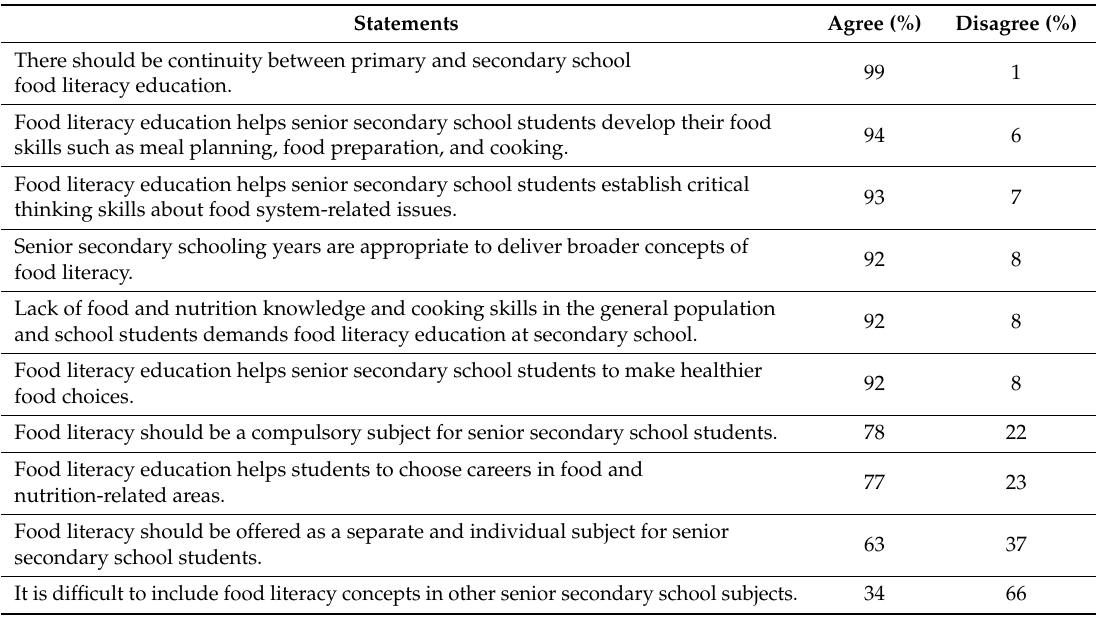
Table 2. Respondents’ agreement with statements related to the importance of food literacy education for senior secondary school students (years 11 and